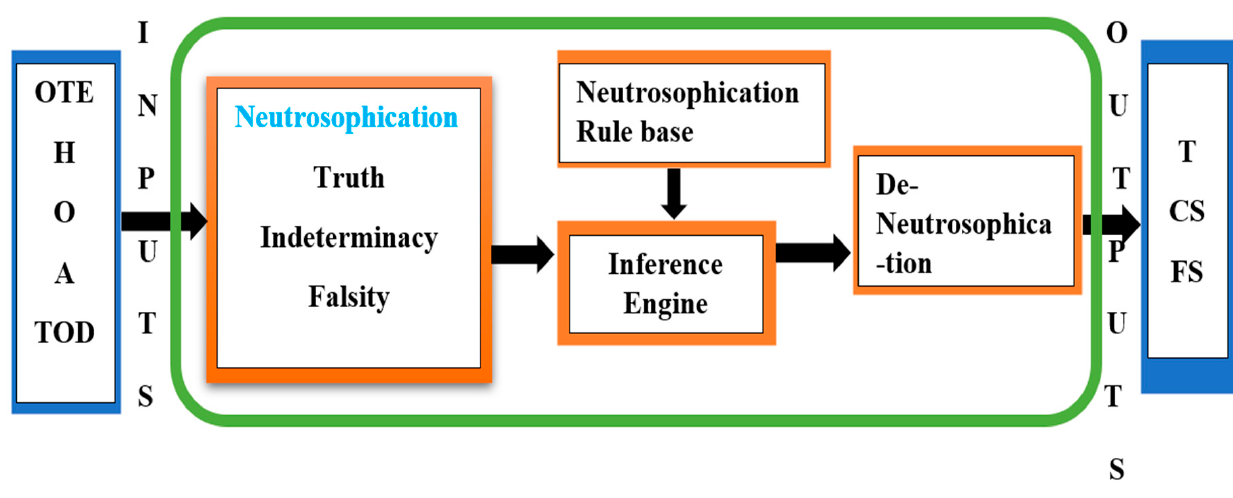
Figure 1. Diagram of the planned system.